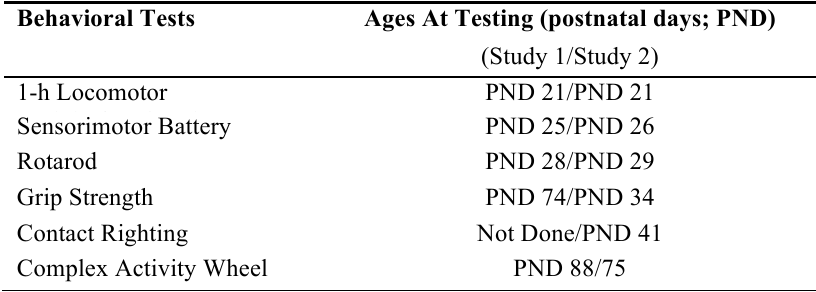
Table 1. Tests to evaluate behavioral effects of multiple neonatal DEX